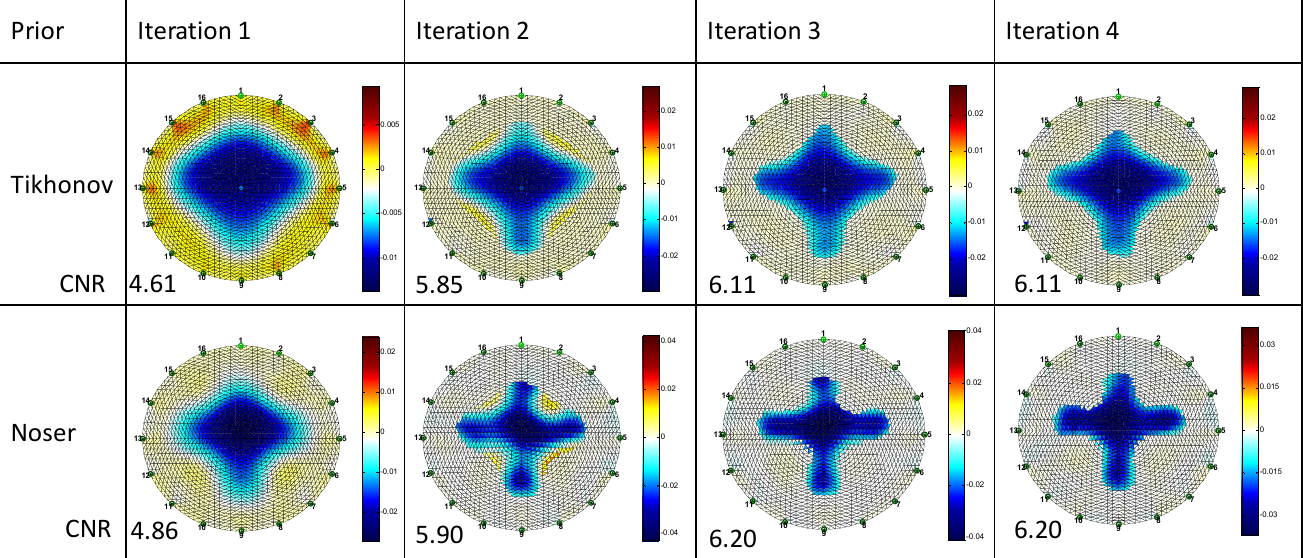
Fig.6: Effect of type of prior on reconstructed image using DeTER.